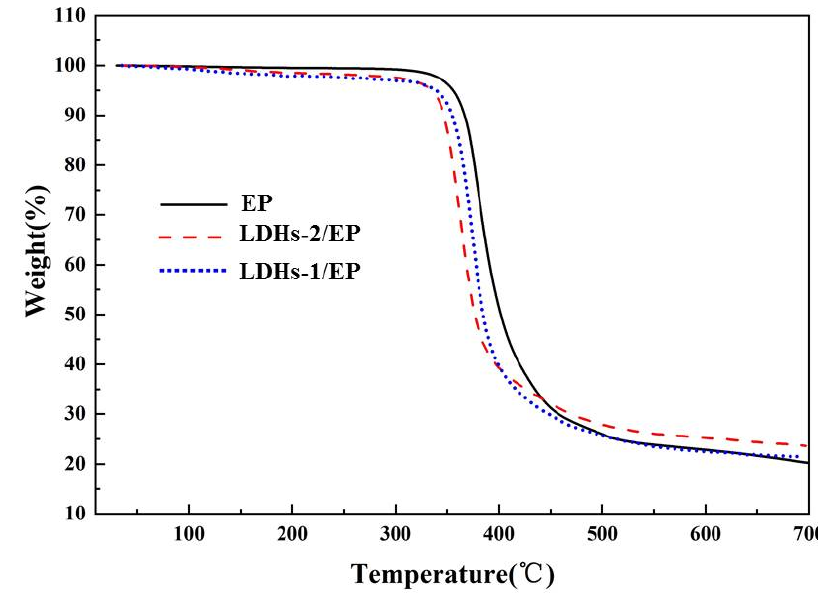
Figure 4. TG images of EP, LDHs-1/EP, and LDHs-2/EP.